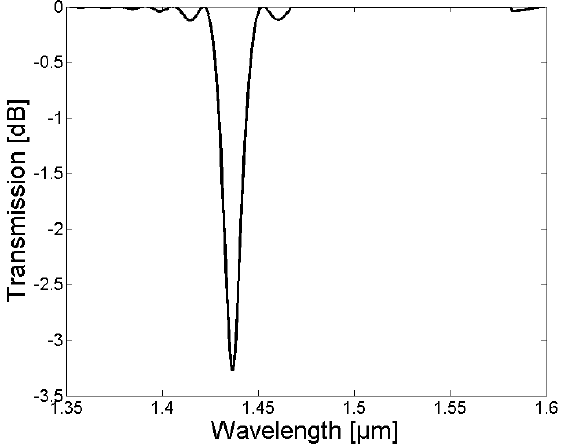
Figure 8. The resulting simulated LPG spectrum in the tapered SM1500 single ‐ mode fiber, with a starting cladding diameter of 80 μ m, an extension of 28 mm, a grating period of 370 μ m, a grating length of 8 mm, and a refractive index change within the grating of δ n = 1 × 10 − 3 .